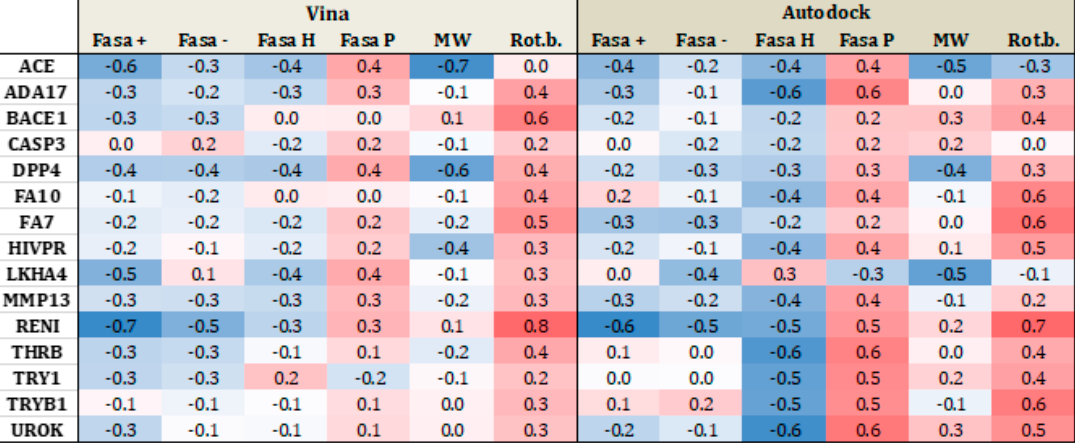
Figure 5. Heat map correlation for proteases between Vina and AutoDock scores and ligand properties, such as fraction of hydrophobic accessible surface area (FASA_H), fraction of polar accessible surface area (FASA_P), fraction of positive and negative accessible surface areas (FASA+ and FASA–), molecular weight (MW), and number of rotational bonds (Rot. B.).